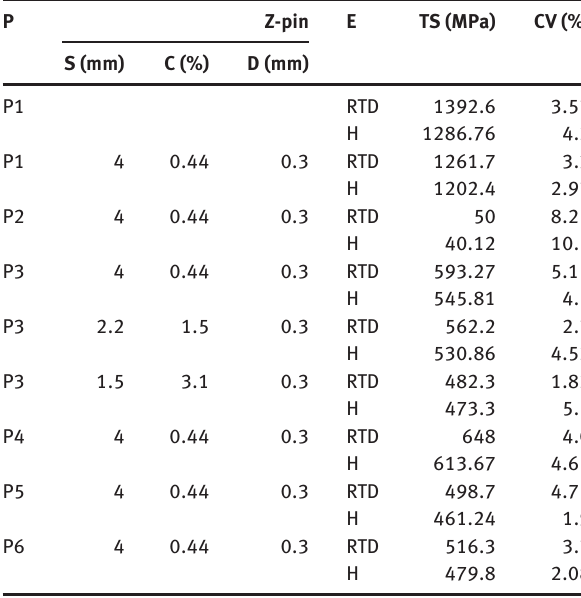
Table 3: Results of the experiments. P